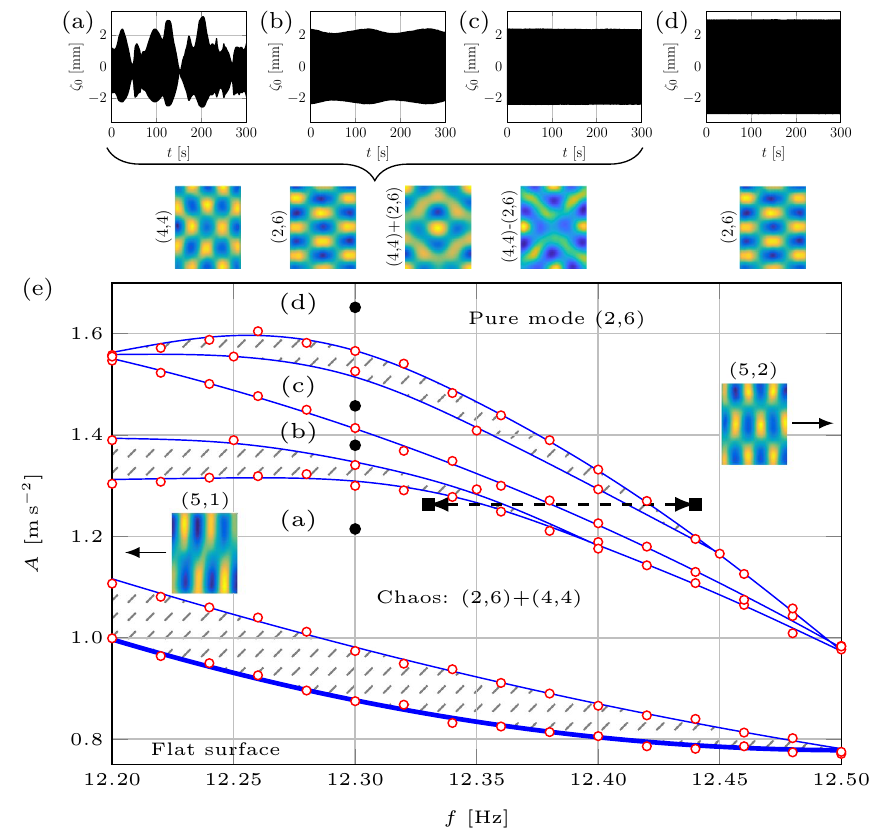
Figure 1. A roadmap. Interactions between modes (2, 6) and (4, 4) on the time-fixed domain of dimensions L × W = 120 mm × 150 mm . Surface deformations ζ 0 ( t ) ( a – d ) corresponding to solid circles in the amplitude- frequency ( A , f ) map ( e ). Four distinct regions exist above the threshold (thick curve): the chaotic ( a ), the periodic time-dependent ( b ) and -independent ( c ) pattern competitions, and time-independent periodic pure mode (2, 6) in ( d ). Below the panels are the patterns observed when the respective ζ 0 ( t ) was recorded: (2, 6) in ( e ) and all of (4, 4), (2, 6), ( 2, 6 ) + ( 4, 4 ) , ( 2, 6 ) − ( 4, 4 ) in ( a – c ). The measurement error of the amplitude A is 10 − 2 m s − 2